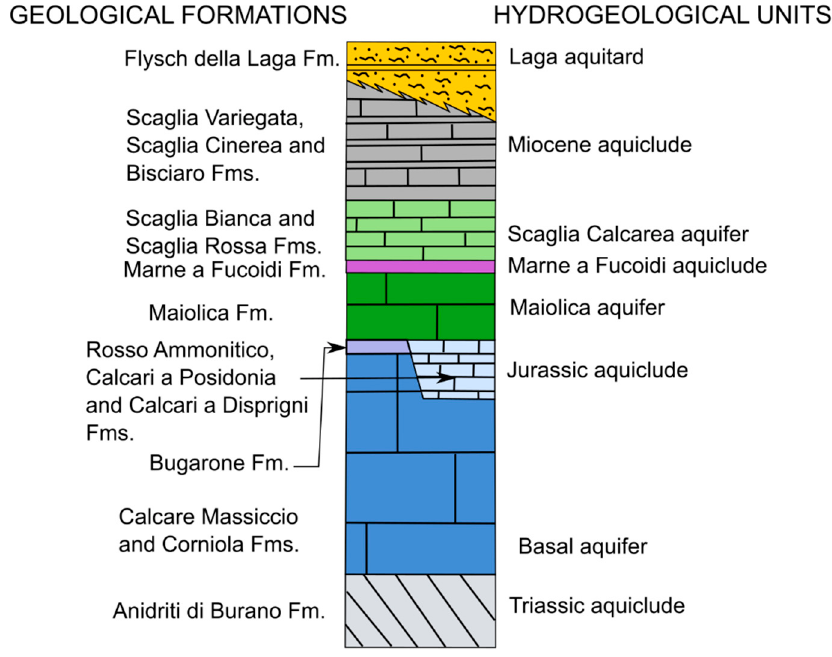
Figure 2. Geological formations and the relative hydrogeological units identified by [45].